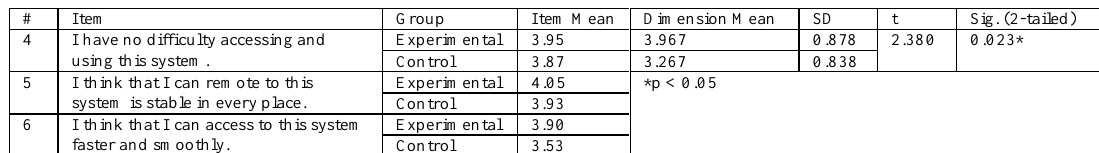
Table 2 System Accessibility of NVBLab.